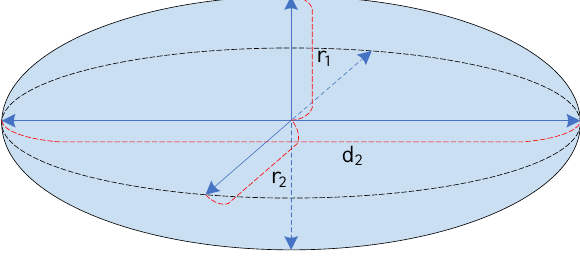
Figure 4. The ellipse model.